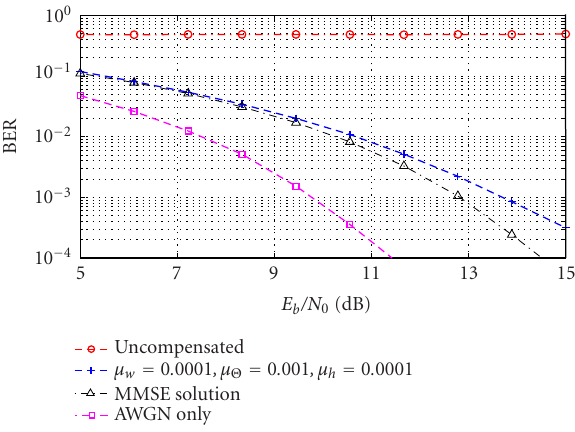
Figure 12: BER performance under combined disturbances of a dispersive channel, a carrier frequency o ff set of ∆Ω = 0 . 3 π , and a modulation index o ff set ∆ h = 0 . 07, with compensation by the CMA, COC, and MIOC, and with parameters K = 9, N = 2, K BT = 0 . 5, h = 0 .